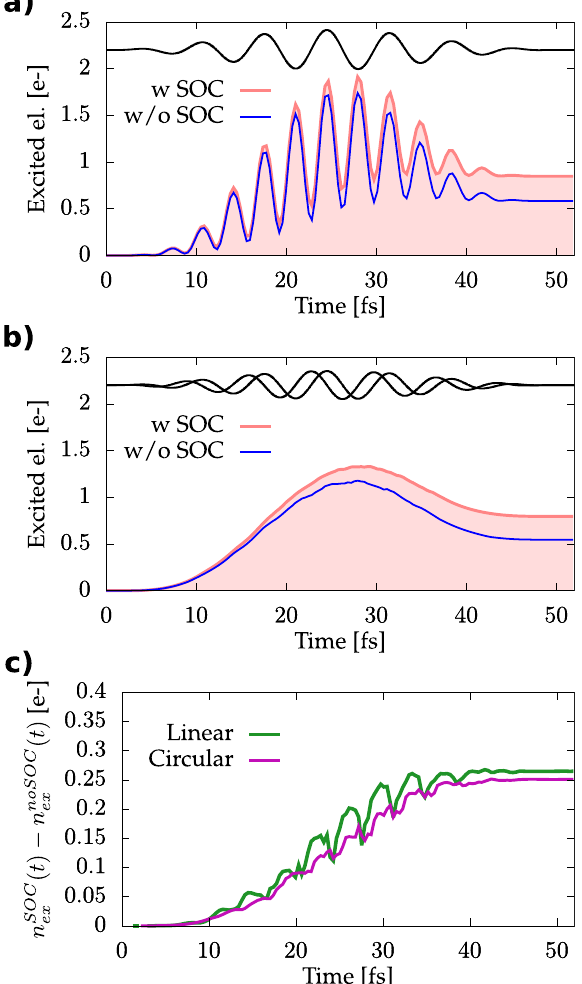
Fig. 3 Effect of SOC on the number of excited carriers. Number of excited electrons for ( a ) a linearly-polarized laser fi eld along the y axis, and ( b ) a LHS circularly-polarized laser pulse with a major axis along the y axis (middle panel), for an intensity in matter of = 4 × 10 11 W.cm − 2 . In each panel, the blue curve corresponds to I 0 the result without SOC and the shaded area corresponds to the result including SOC. c Shows the difference in the number of excited electrons induced by SOC, for the linearly polarized and for the circularly polarized cases. In ( a ) and ( b ), the time evolution of the vector potential is shown in black.